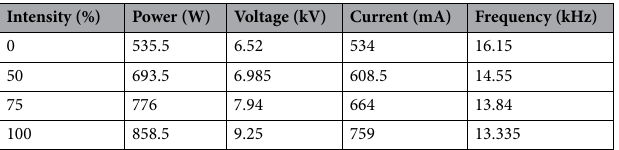
Table 1. Characterization of DCSBD parameters. Values recorded as average of two measurements.